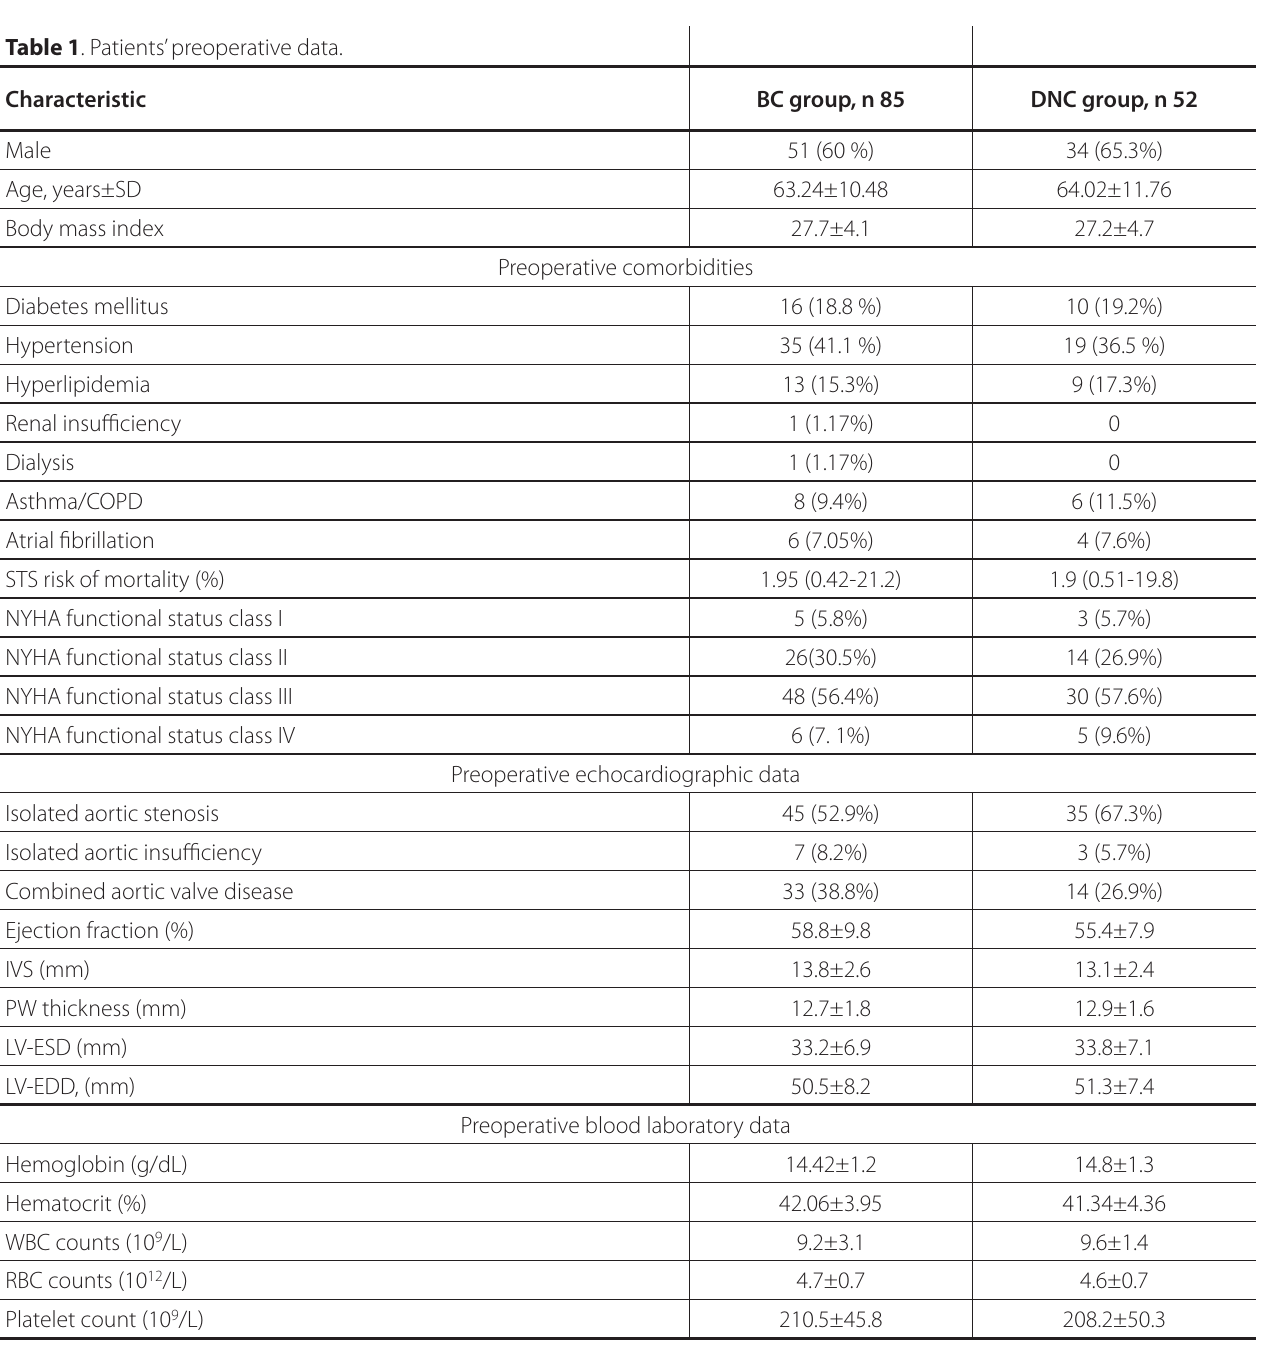
Table 1 . Patients’ preoperative